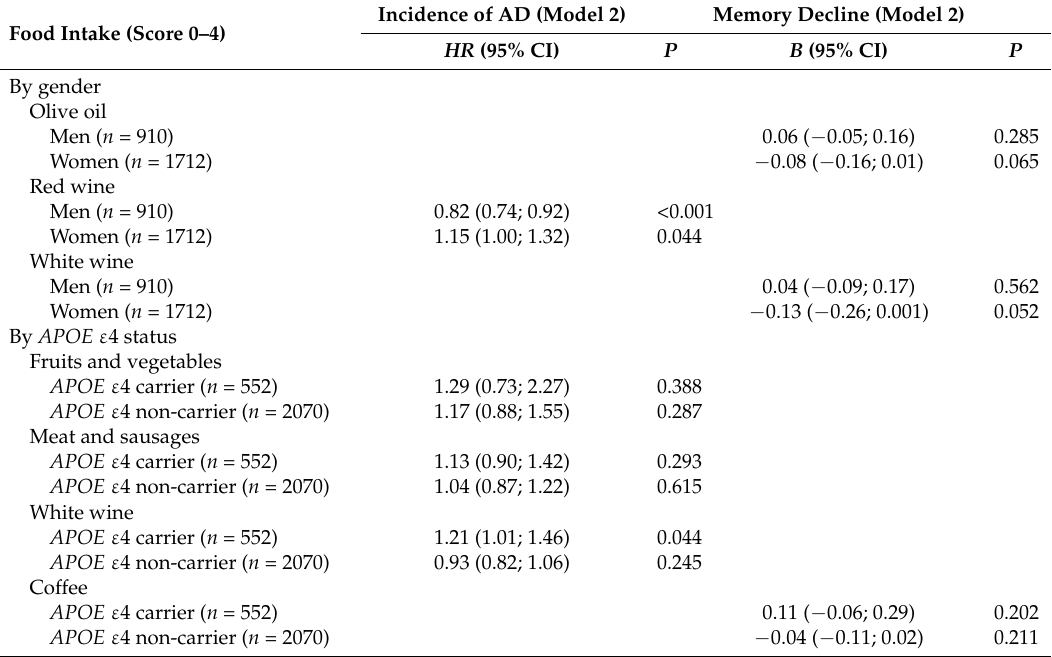
Table 4. Analyses stratified by gender or APOE ε 4 status (performed only when P for interaction <0.10 in the main analyses, as shown in Table